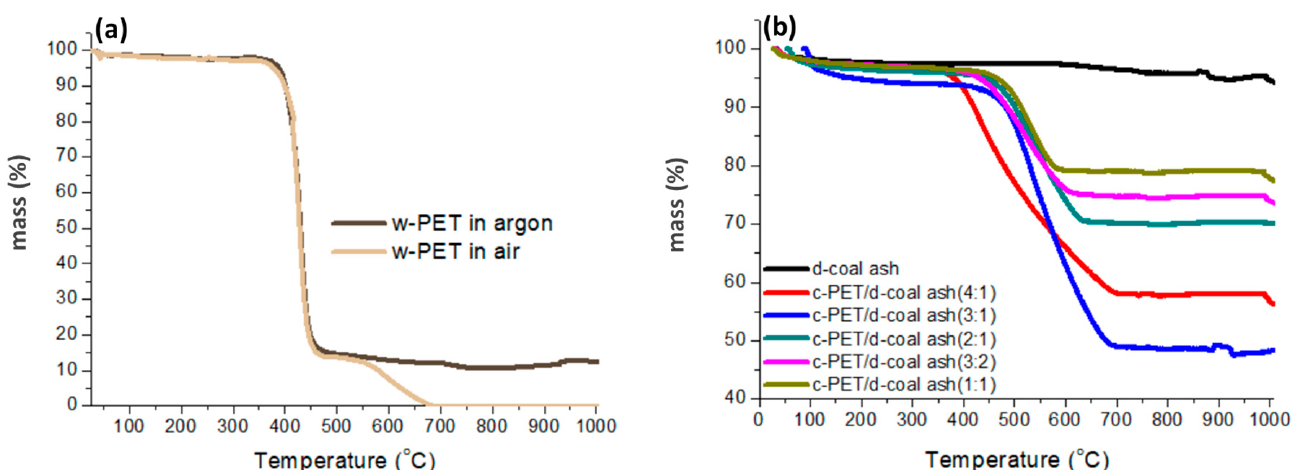
Figure 4. Thermal decomposition of w-PET and resultant c-PET from direct carbonization and co- carbonization with d-coal ash: ( a ) TGA thermogram of raw w-PET under an argon flow of 3 L/min (and static air) at heating rate of 10 °C/min up to 1000 °C and ( b ) TGA thermograms of di ff erent c- PET/d-coal ash composites from ambient temperature to 1000 °C under static air and a heating rate of 10 °C/min.